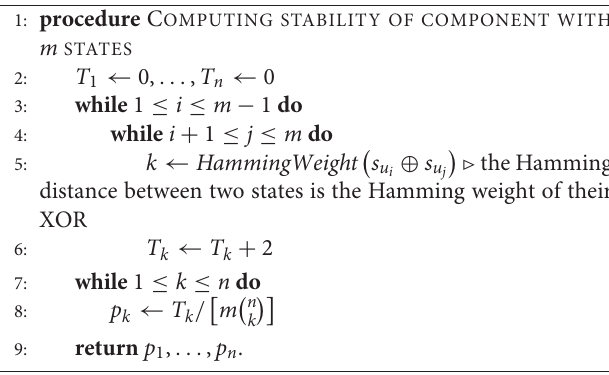
Algorithm 4 Stability of given connected